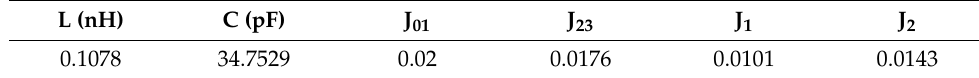
Figure 1. Circuit model with J-inverters and identical inductor-capacitor resonators. Table 1. This Calculated Circuit Model Design Parameters.